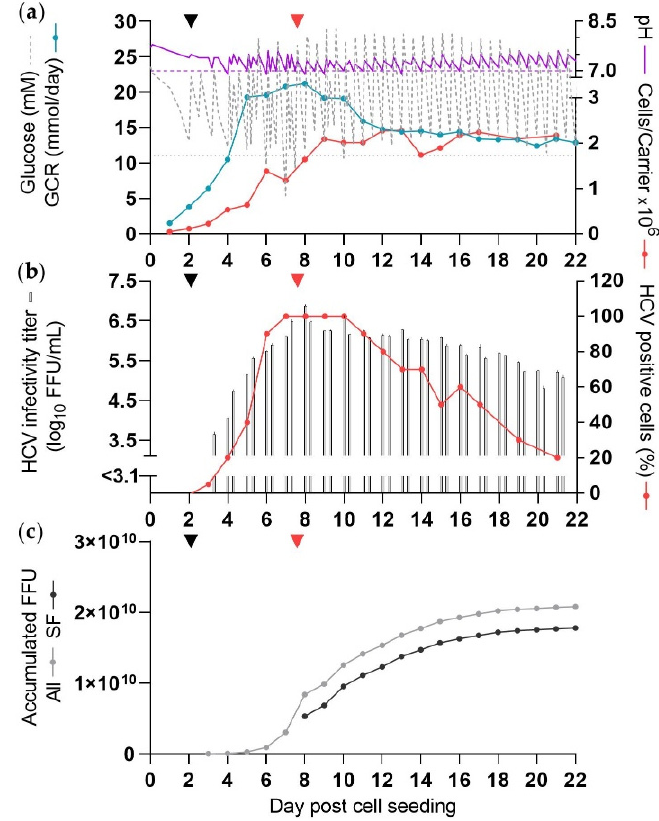
Figure 3. SF HCV production in the CelCradle™ with additional BioNOCII™ carriers for increased cell numbers (CC*-DMEx2-SFM). The culture was seeded with 1.7 × 10 ⁵ cells/carrier (10.7 g BioNOCII™ carriers) and infected with 2 × 10 ⁶ FFU at 2 dpcs (black arrow), as described in Figure 1. Purple dashed line: pH 7, grey dotted line: 11 mM glucose. At 2 and 3 dpcs medium was exchanged in the evening and from 4 dpcs medium was exchanged each morning and evening. Glucose and/or NaHCO 3 solution was added upon DME as required, and at 5–16 dpcs in the morning, afternoon and evening. Glucose concentration and pH were measured up to six times per day, each time before and after DME and/or addition of glucose and NaHCO 3 solution. Carriers were sampled daily until 17 dpcs and then less frequently. From 7 dpcs the culture was maintained in SFM (red arrow). ( a ) Glucose concentration, pH, GCR, and cells/carrier. ( b ) HCV infectivity titers (two per day) and percentage HCV NS5A positive cells. ( c ) Accumulated FFU calculated according to harvest volumes of 450 mL.